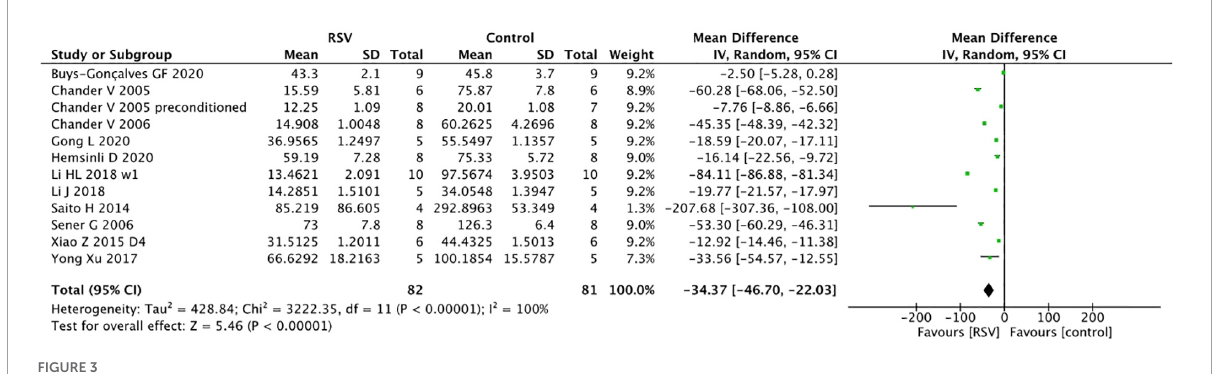
FIGURE3 Forest plot for the effects of resveratrol on blood urea nitrogen.